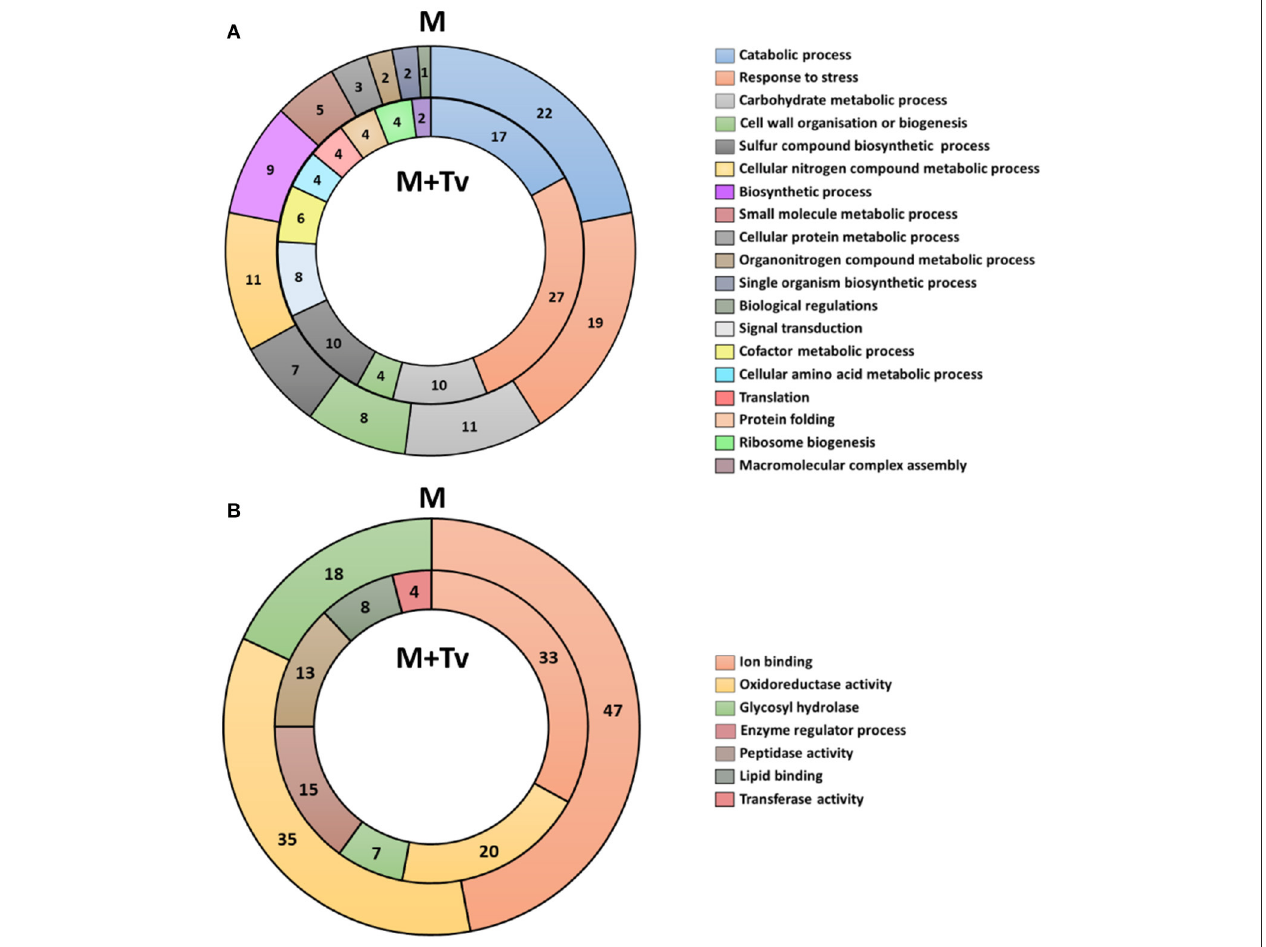
FIGURE 3 | Functional classification of all secreted proteins from un-inoculated and inoculated maize roots at 5 days interaction. (A) Blast2GO multilevel chart for biological process of un-inoculated (M) and inoculated (M + Tv) maize roots. (B) Multilevel chart for molecular function of un-inoculated and inoculated maize roots. Score distribution represented as a percentage of each group is indicated inside the pie